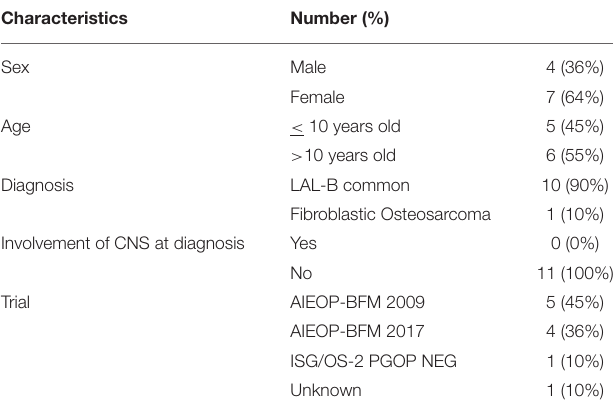
TABLE 2 | Clinical data of our study